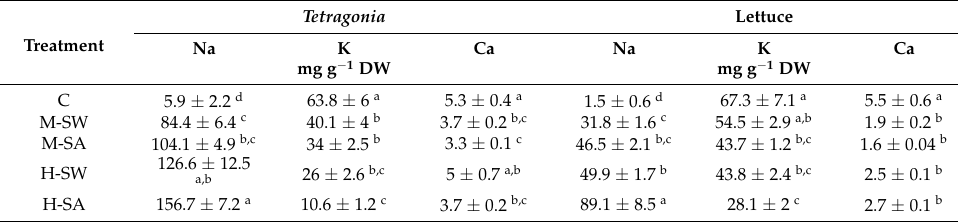
Table 4. The Na, K and Ca concentration in edible leaves for different